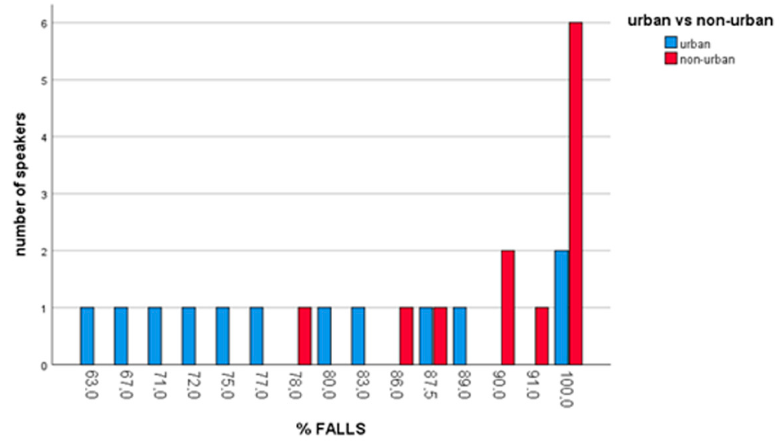
Figure 6. Percentage of interrogative sentences ending in a falling contour in urban and non-urban areas.